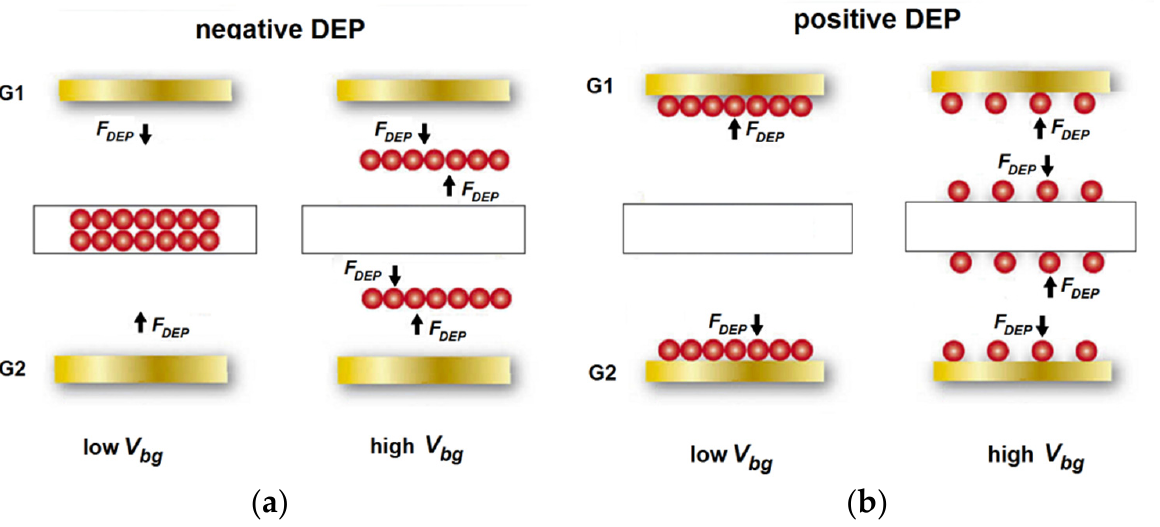
Figure 8. Schematic images of the ( a ) negative DEP and ( b ) positive DEP at different V bg voltages for the SOI-FET sensor.